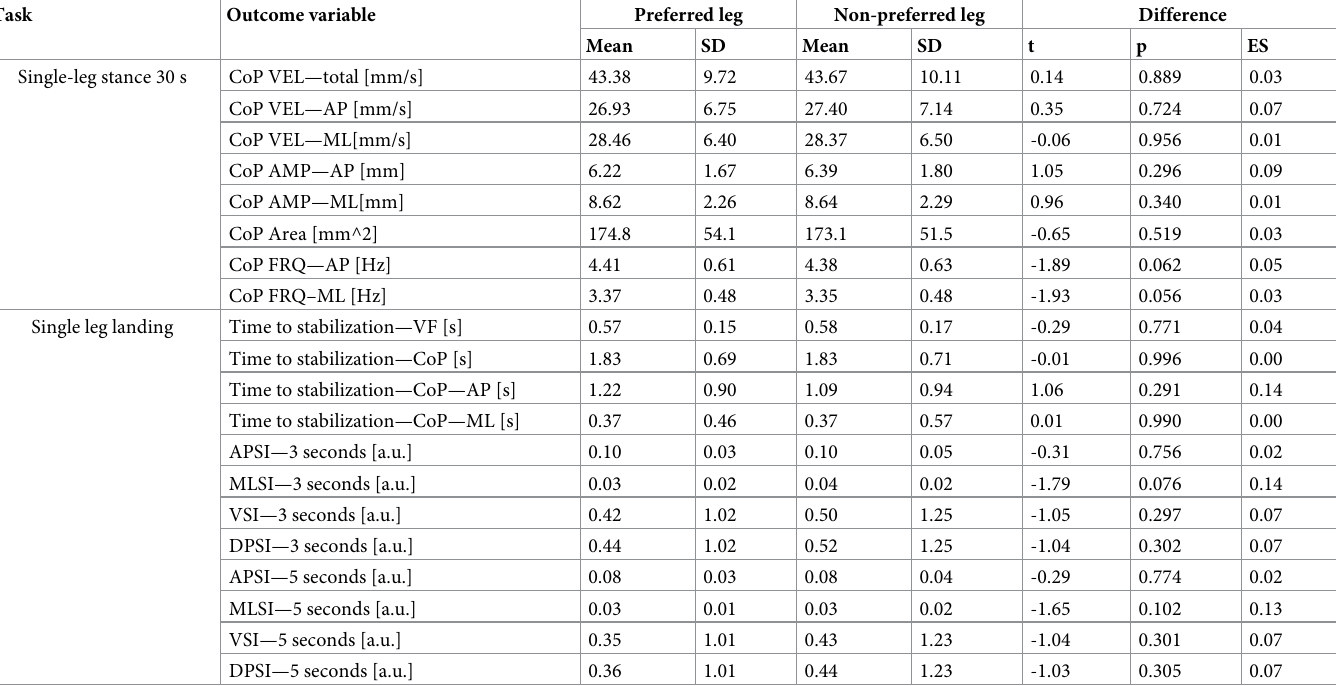
Table 2. Effect of leg preference (for single-leg jumping) on body sway and landing variables. Task Outcome variable Single-leg stance 30